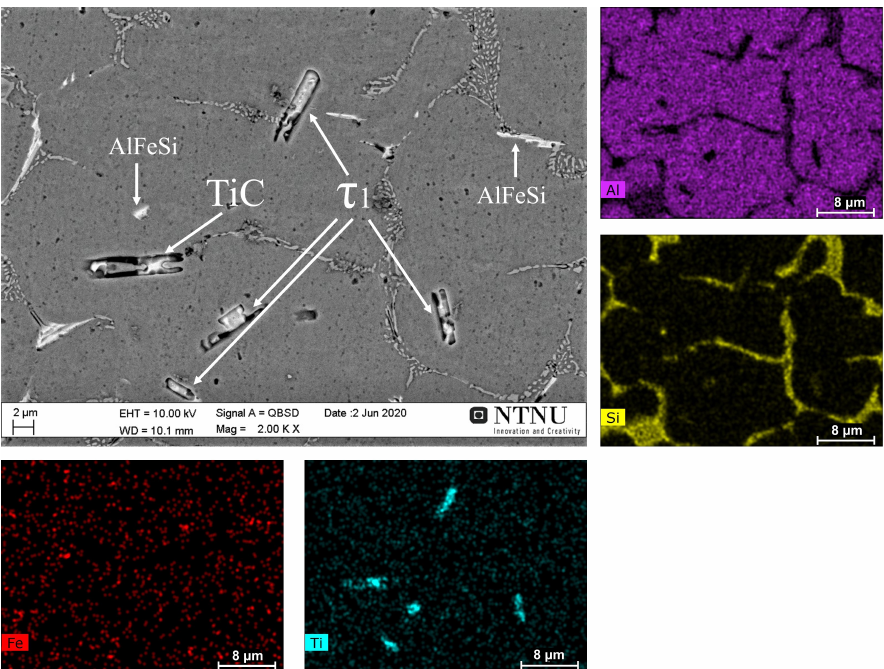
Figure 11. EDS map of metal screw extruded AA4043-TiC after bead-on-plate deposition. Ti-containing phases and AlFeSi intermetallics are marked with white arrows. Titanium particles were mainly distributed on grain boundaries.